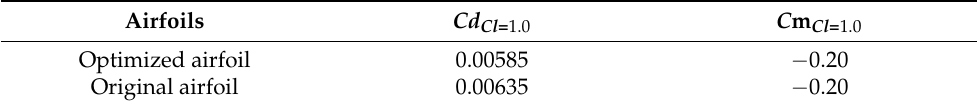
Table 3. Optimized